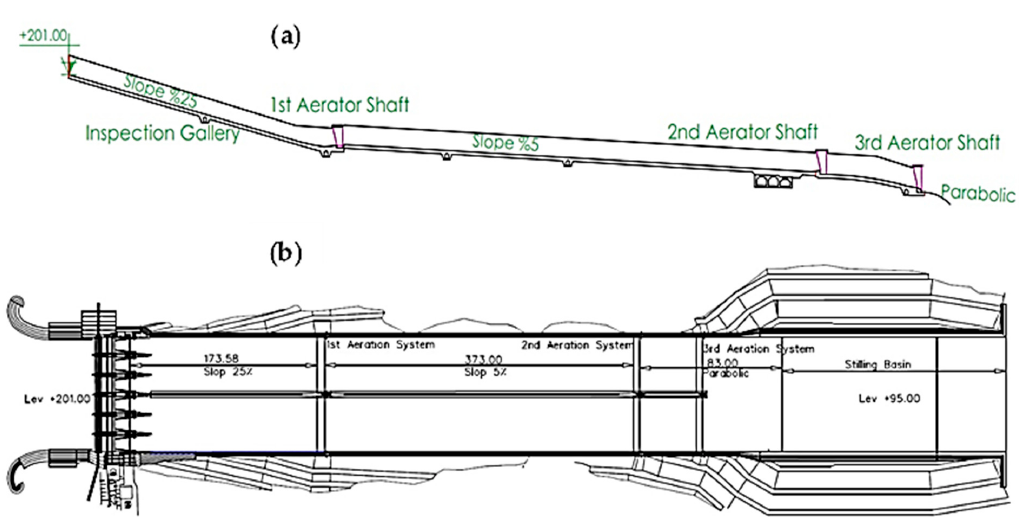
Figure 14. Chute and aeration system of the Karkheh Dam: ( a ) Section view, ( b ) plan view.